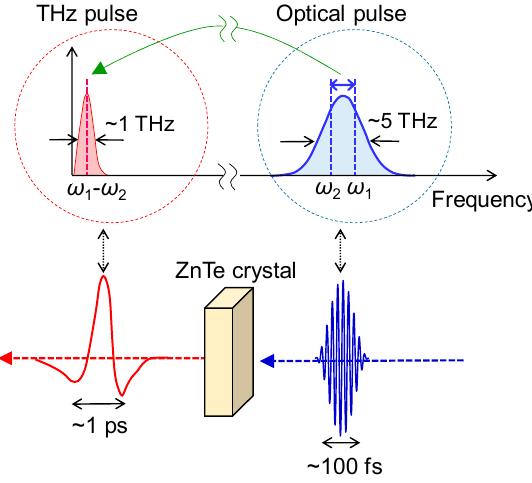
Figure 9. Schematic of a terahertz-pulse generation by an optical rectification (differential frequency generation) process in a ZnTe crystal.